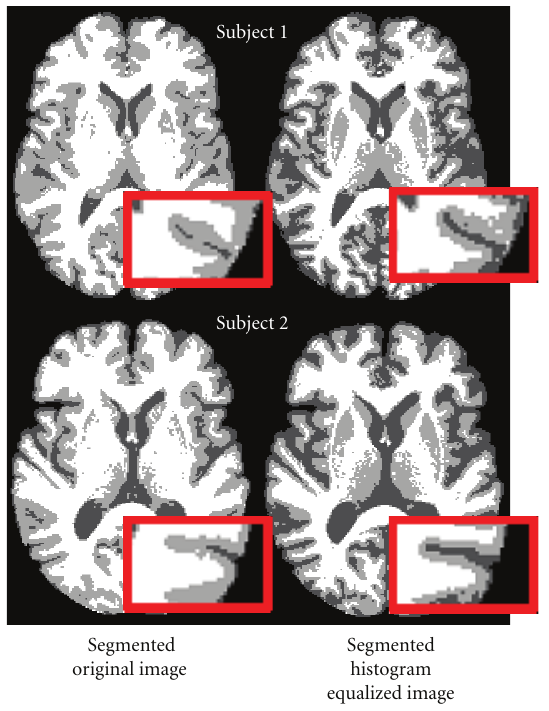
Figure 4: The figure shows the hard segmentation of two di ff erent subjects with and without histogram equalization before segmen- tation. This specific example shows how disconnected CSF spots become connected when applying histogram equalization before segmentation, thereby increasing the consistency of the CSF class between the two di ff erent